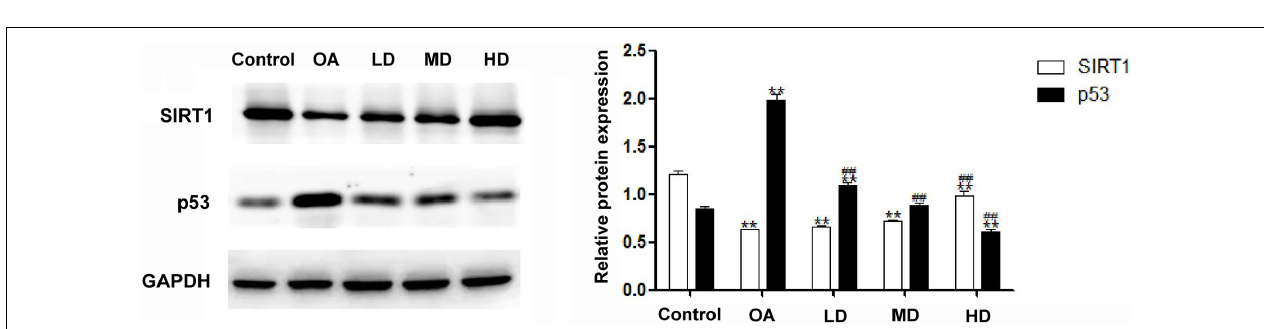
FIGURE 3 | H&E staining and Mankin score evaluation of articular cartilage of the knee in different groups. (A) H&E staining showed articular cartilage of the knee in different groups (200X). (B) Mankin score evaluation of different groups. * P < 0.05.